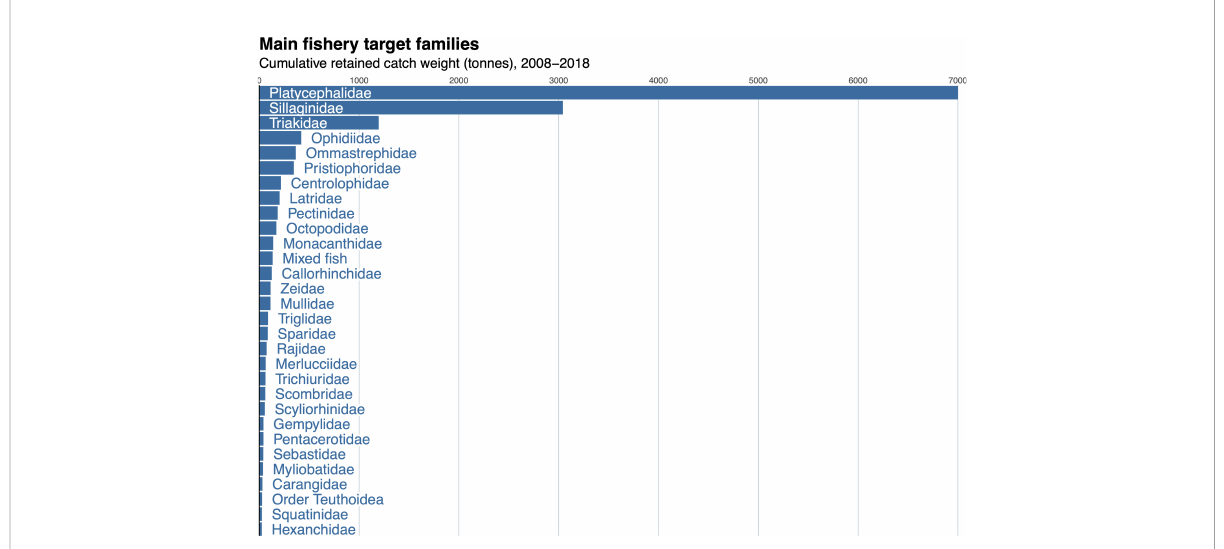
FIGURE 4 Cumulative fi shery catch near oil and gas structures in the Bass Strait from 2008-2018 by